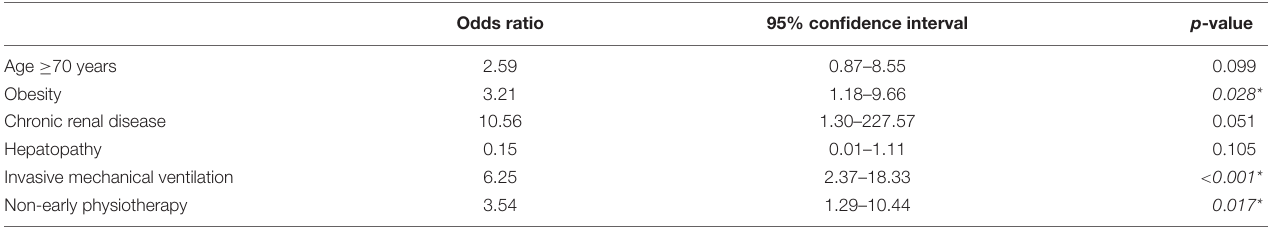
TABLE 3 | The multivariate analysis of prolonged hospitalization ( > 28 days) of subjects receiving physiotherapy during admission.